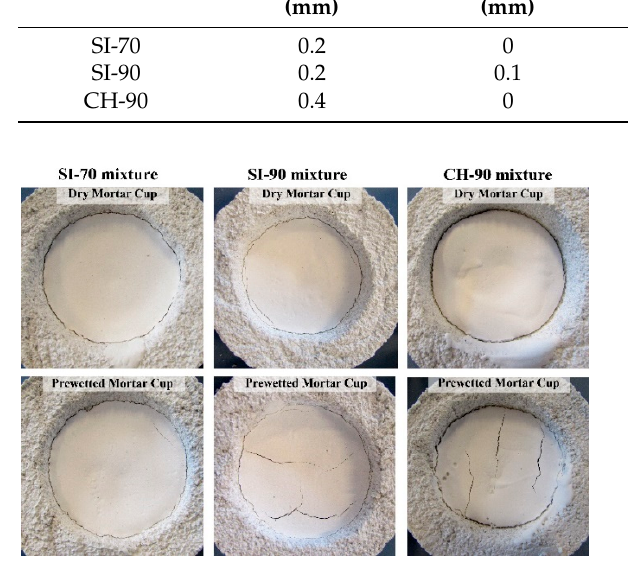
Figure 2. Grout mixtures SI and CH after drying in mortar cups.